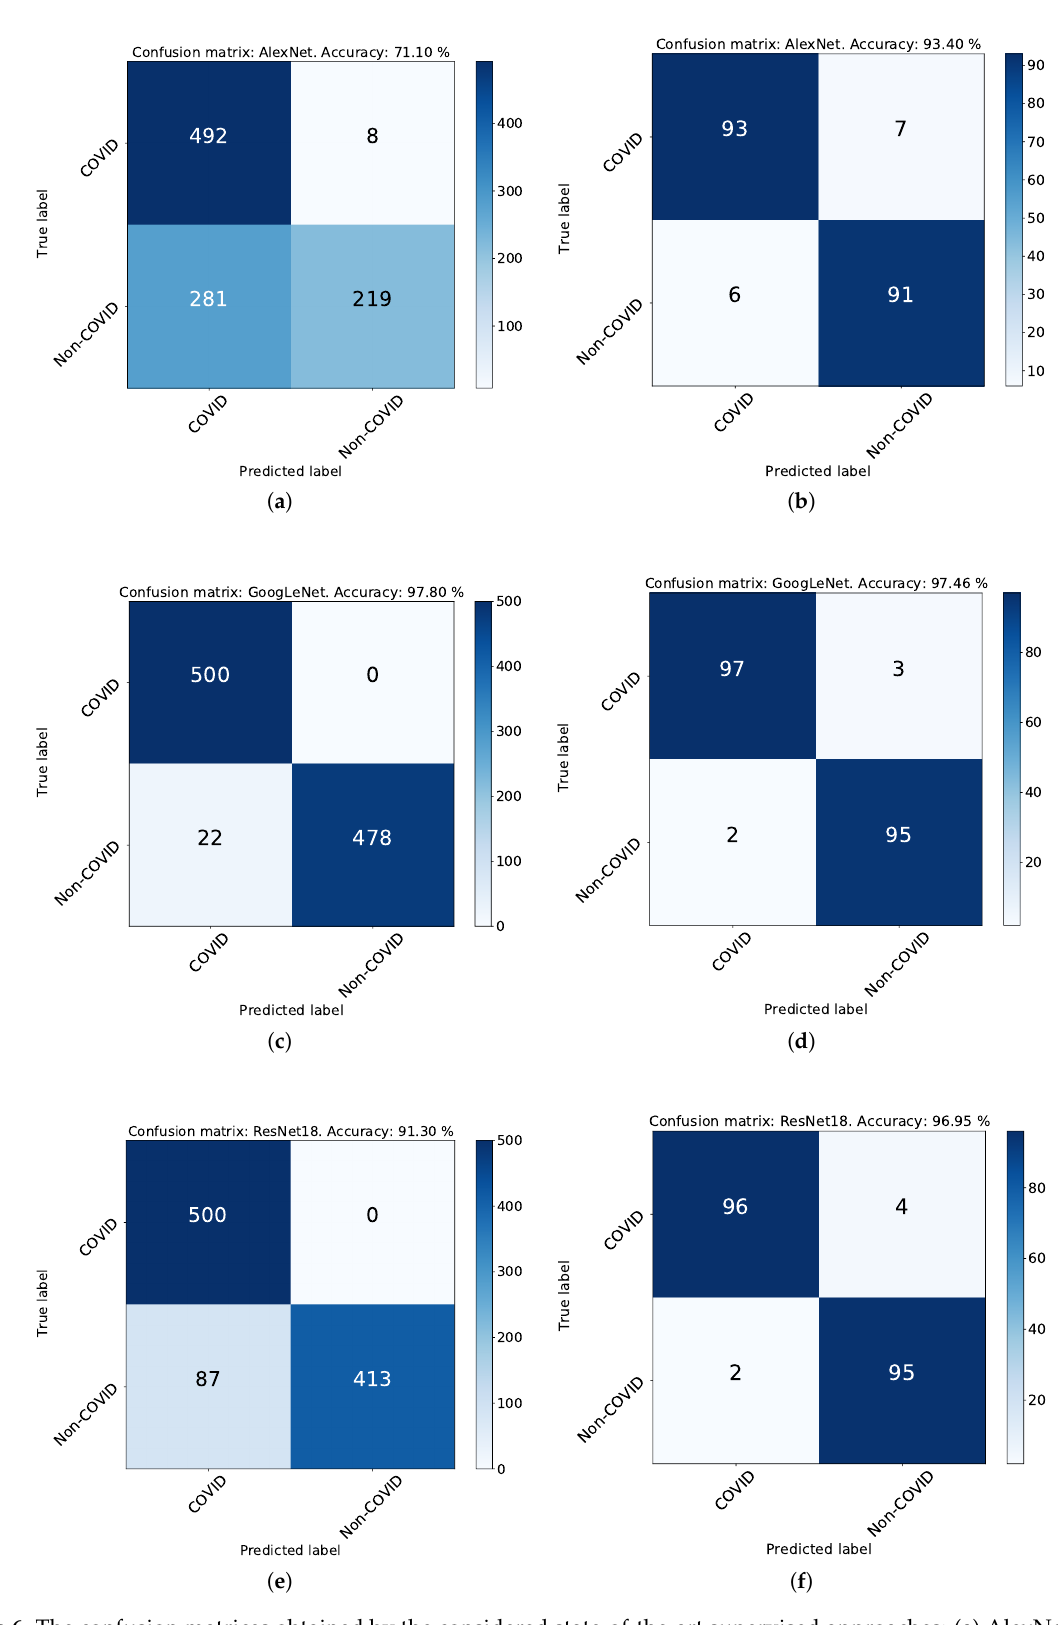
Figure 6. The confusion matrices obtained by the considered state-of-the-art supervised approaches: ( a ) AlexNet for CT, ( b ) AlexNet for CXRs, ( c ) GoogLeNet for CT, ( d ) GoogLeNet for CXRs, ( e ) ResNet18 for CT, and ( f ) ResNet18 for